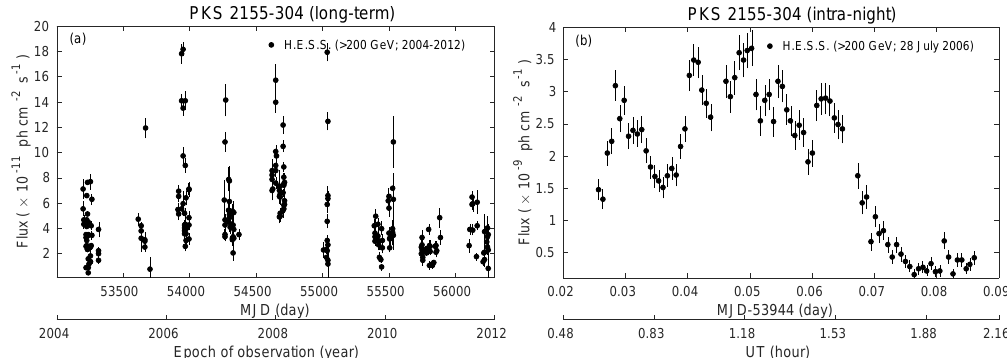
Figure 1. The long-term ( a ) and intra-night ( b ) H.E.S.S. light curves of the